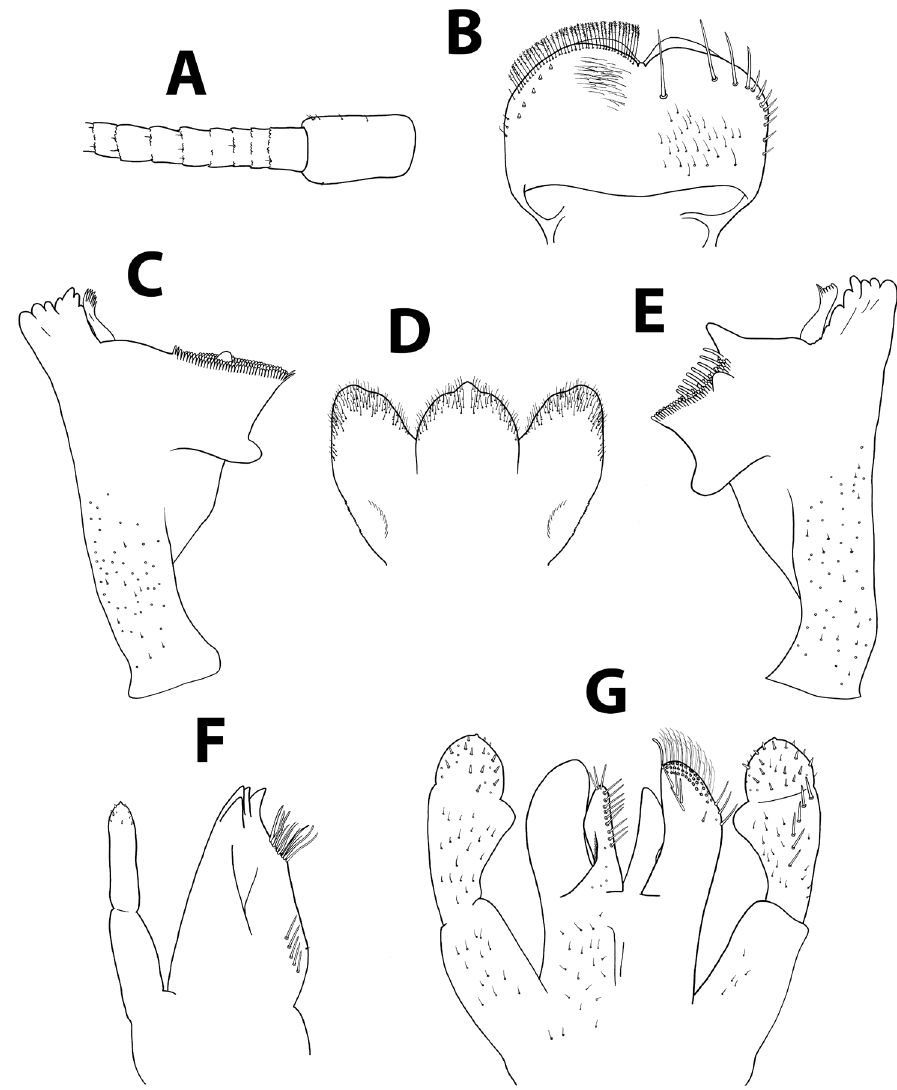
Figure 7. Baetis golanensis sp. n., nymph. A antennal pedicel and first flagellomeres B labrum (left, ventral; right, dorsal) C right mandible D hypopharynx E left mandible F maxilla G labium. prostheca and mola without setae or crenulation, mola apex with tuft of setae; base of mandible with many short, thin setae and seta bases. Left mandible (Figure 7E) with incisors composed of six denticles; prostheca with four broad denticles and comb-shaped structure; space between prostheca and mola without setae or crenula- tion; base of mola without spines; base of mandible with many setae and seta bases. Maxillae (Figure 7F) with four broad teeth; lacinia with one row of small setae and long, serrated setae; base of lacinia with row of five long, stout setae; one